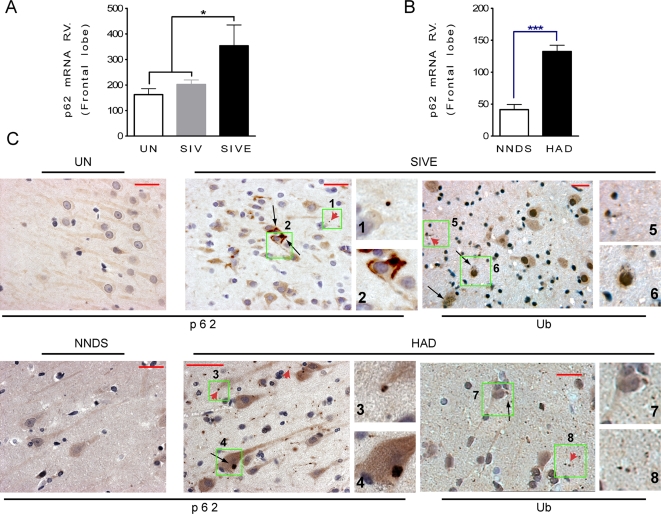
Transcriptional regulation of p62 in SIVE monkey brains, and its presence in human and monkey neurons associated with ubiquitin.(A) Relative values (RV) of p62 mRNA level in frontal lobe of SIVE versus SIV and uninfected (UN) monkeys, n = 7 for SIVE, n = 12 for SIV and n = 9 for UN, P<0.05. (B) RV of p62 mRNA level in frontal cortex of HAD versus non neurological diseased subjects (NNDS), n = 8 for HAD and n = 10 for NNDS, P<0.0001. (C) p62 and ubiquitin immunoreactivity on serial sections in SIVE monkeys, as well as those with HAD in brain sections from hippocampus. p62 has a diffuse immunoreactivity in UN monkeys and in human NNDS and a dot profile structures in SIVE and HAD brain tissues. Higher magnification views are shown in green insets. Black arrows indicate p62- or ubiquitin-immunoreactive structures within the neuronal cell body or proximal processes, and red arrowheads indicate a dot-like immunoreactivity in the neuropil. Scale bar, 20 µm.